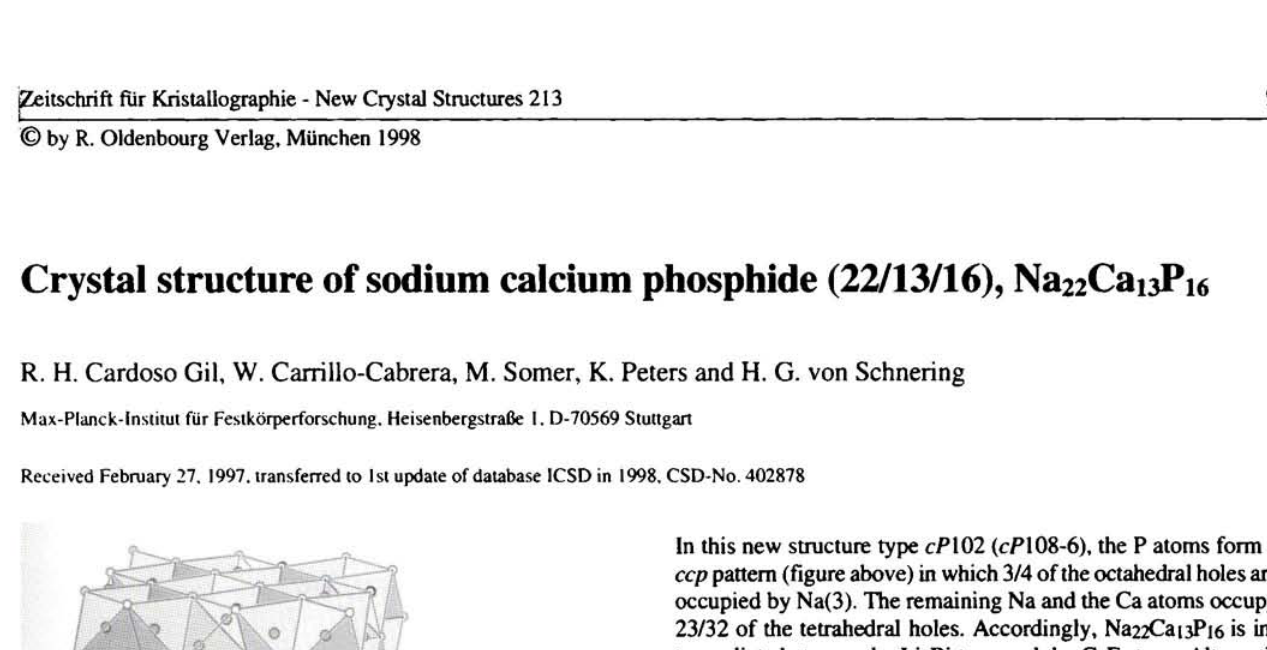
Table 1. Parameters used for the X-ray data collection